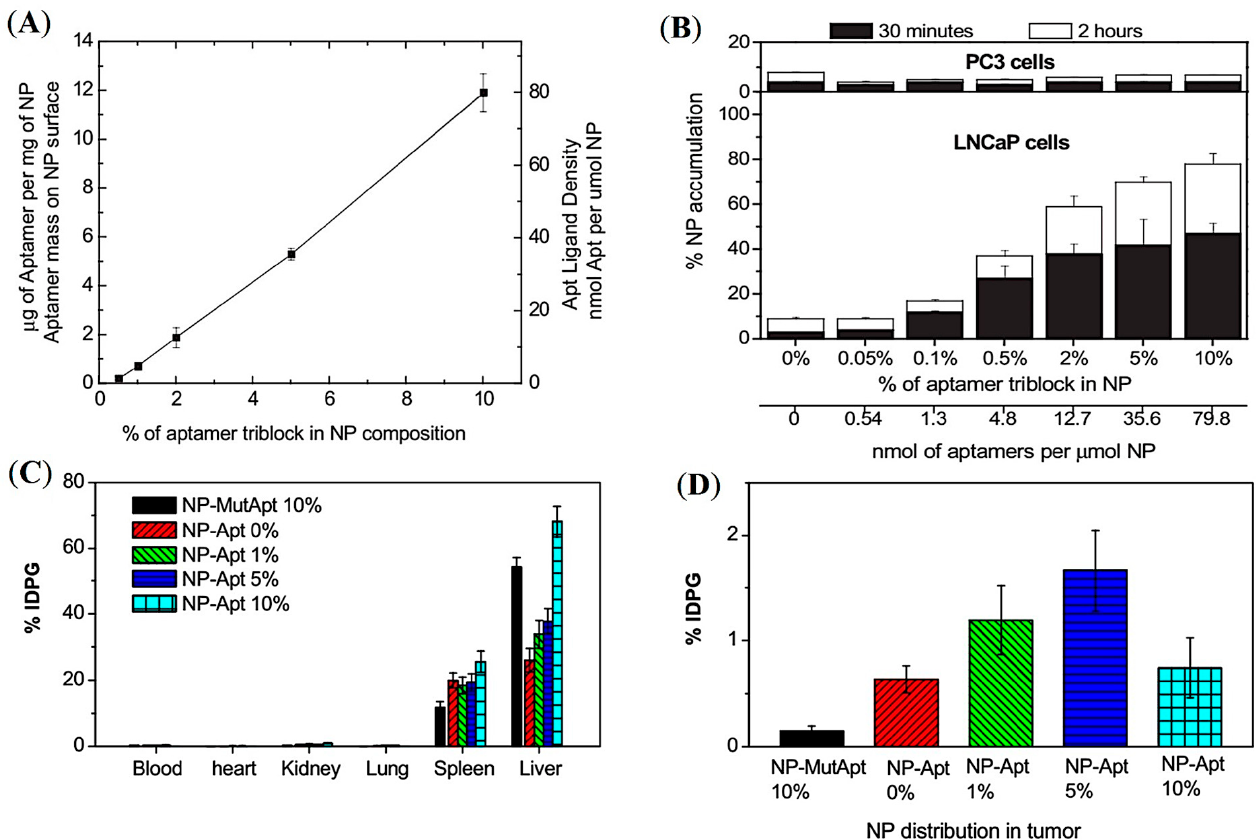
Figure 5. Development of PSMA-targeted amphiphilic block copolymers using aptamers as a targeting ligand. ( A ) Quantification of aptamer ligand density on the PLGA-b-PEG nanoparticle surface. ( B ) Cell uptake assay of 3 H-labelled NPs in LNCaP and PC3 cells. ( C , D ) Ex vivo biodistribution of NPs with different % of aptamer conjugated PLGA-b-PEG polymer in LNCaP tumor-bearing mice administered by retro-orbital injection. Reprinted with permission from Ref [50]. Copyright 2008, National Academy of Science.